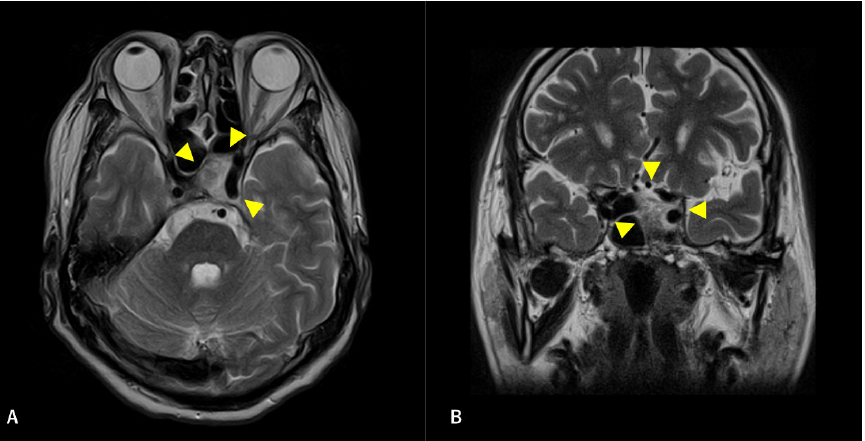
Figure 2. Preoperative T2-weighted magnetic resonance image (MRI) findings. Axial section ( A ) and coronal ( B ) images are shown. A high-intensity mass is observed in the left sphenoid sinus. The ICA is surrounded by a mass. Arrowheads indicate tumors.